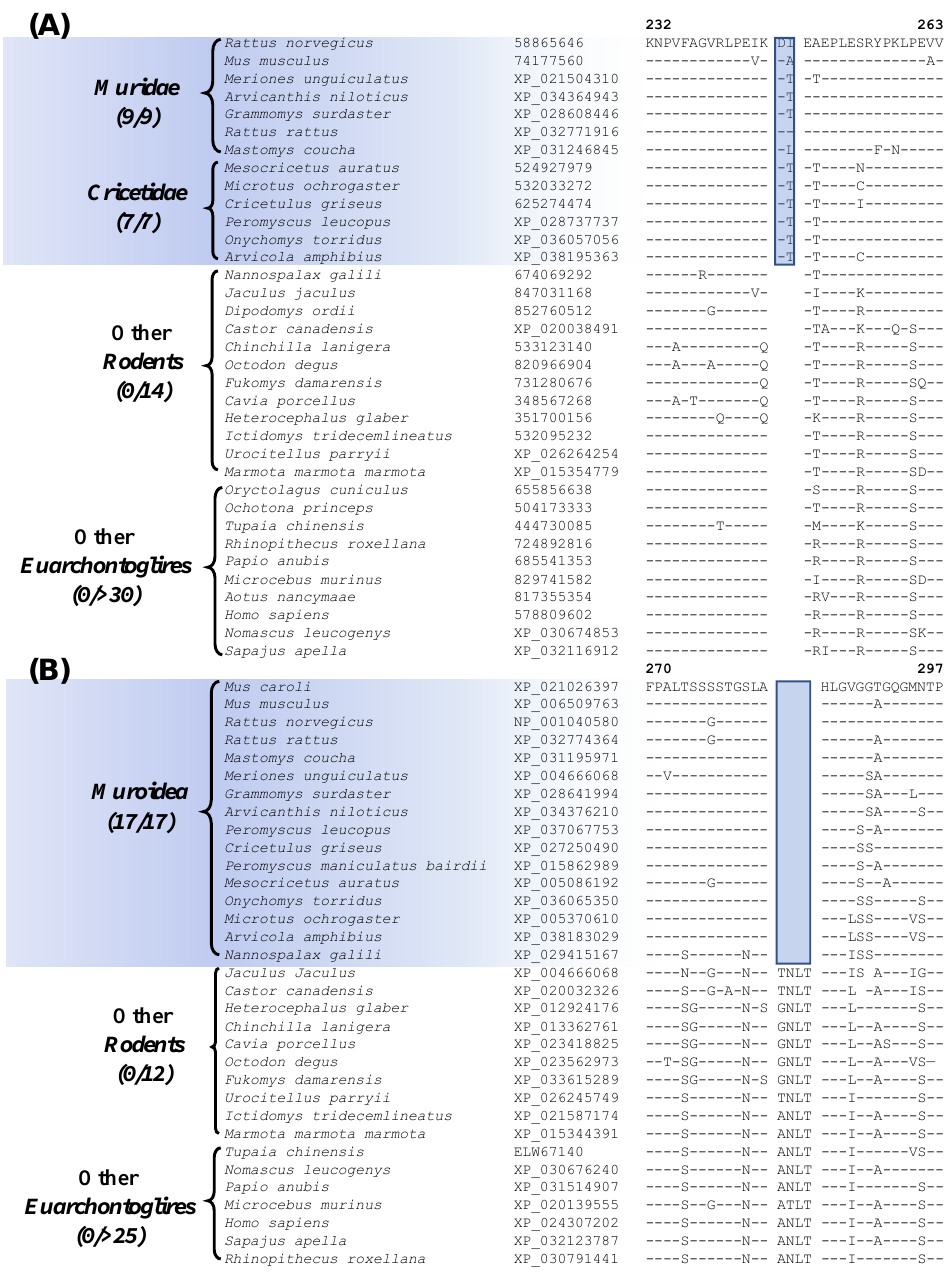
Figure 7. ( A ) Partial sequence alignment of the protein cyclin-dependent kinase-like 2, containing